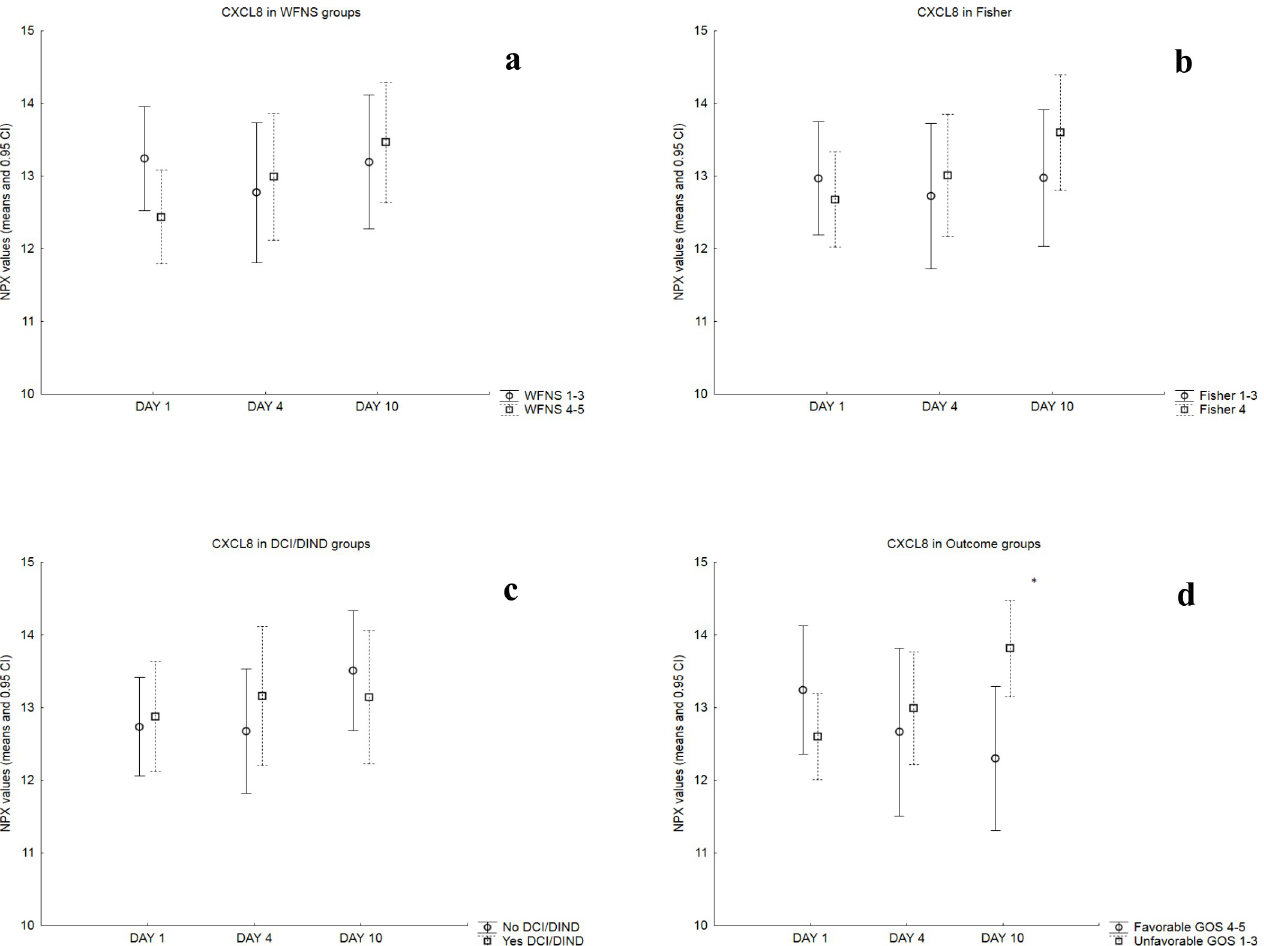
Fig 3. Comparisons of CXCL8 NPX values in patient groups: Mean NPX values and 0.95 CI for each day in dichotomized patient groups based on a) WFNS score on admission ( top left ), b) Fisher scale of admission CT ( top right ), c) occurrence of DCI/DIND ( bottom left ) and d) clinical outcome ( bottom right ). The asterisk on the bottom right image marks significantly higher day 10 mean NPX values for patients with unfavorable outcome.